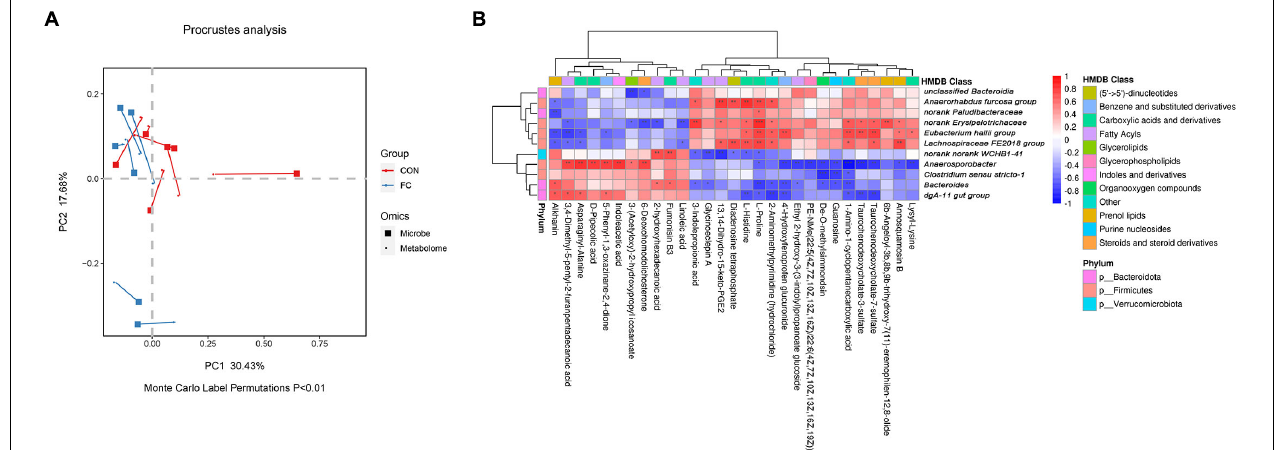
FIGURE 7 | Correlation between serum metabolites and fecal microbial taxa in ewes. (A) Procrustes analysis of fecal microbiome and serum metabolome in ewes with follicular cyst and normal follicle. Fecal and serum samples are showed as squares and dots, respectively. Fecal and serum samples from the same individual are connected by red (control ewes) and blue (follicular cyst ewes) lines. (B) Correlation analysis between fecal microbiome and serum metabolome in the ewes with follicular cyst and normal follicle. Red represents a positive correlation, while blue represents a negative correlation. *Significant correlation between fecal microbiome and serum metabolome ( P < 0.05), **significant correlation ( P < 0.01), and ***significant correlation ( P <